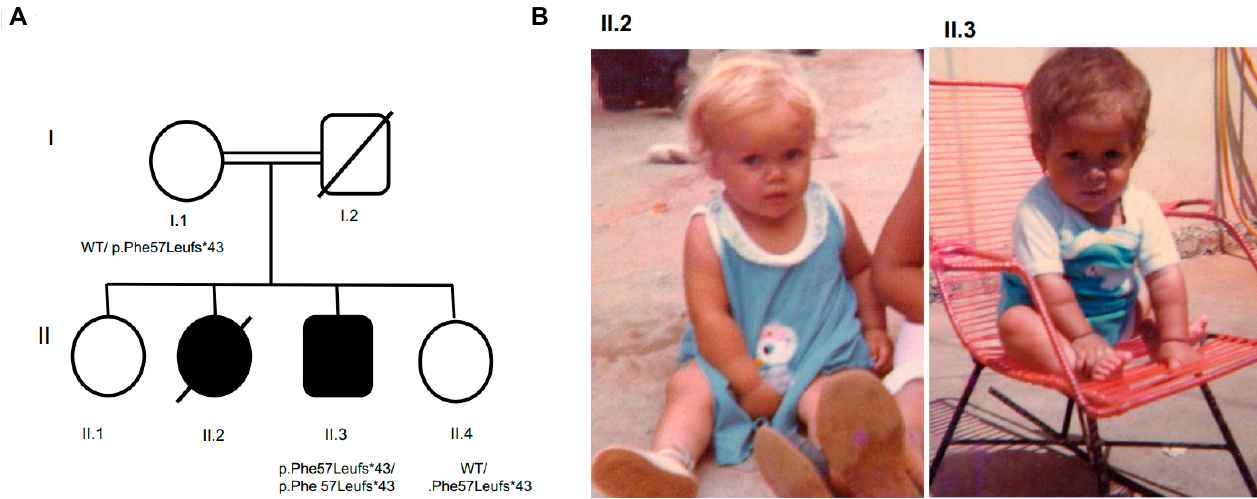
Figure 1. Pedigree and inheritance of the GH1 c.171delT (p.Phe 57Leufs*43) allelic variant ( A ). Pedigree of the proband II.3 indicating recessive inheritance of p.Phe57Leufs*43 ( B ). Photographs (obtained with permission) of the proband (II.3, far right) and his sister (II.2) with features of growth hormone deficiency.